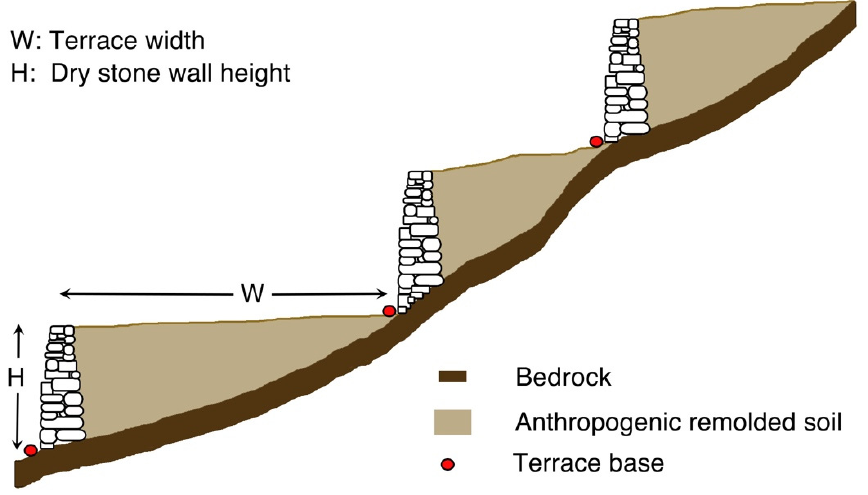
Figure 1. Schematic profile of a terraced slope.